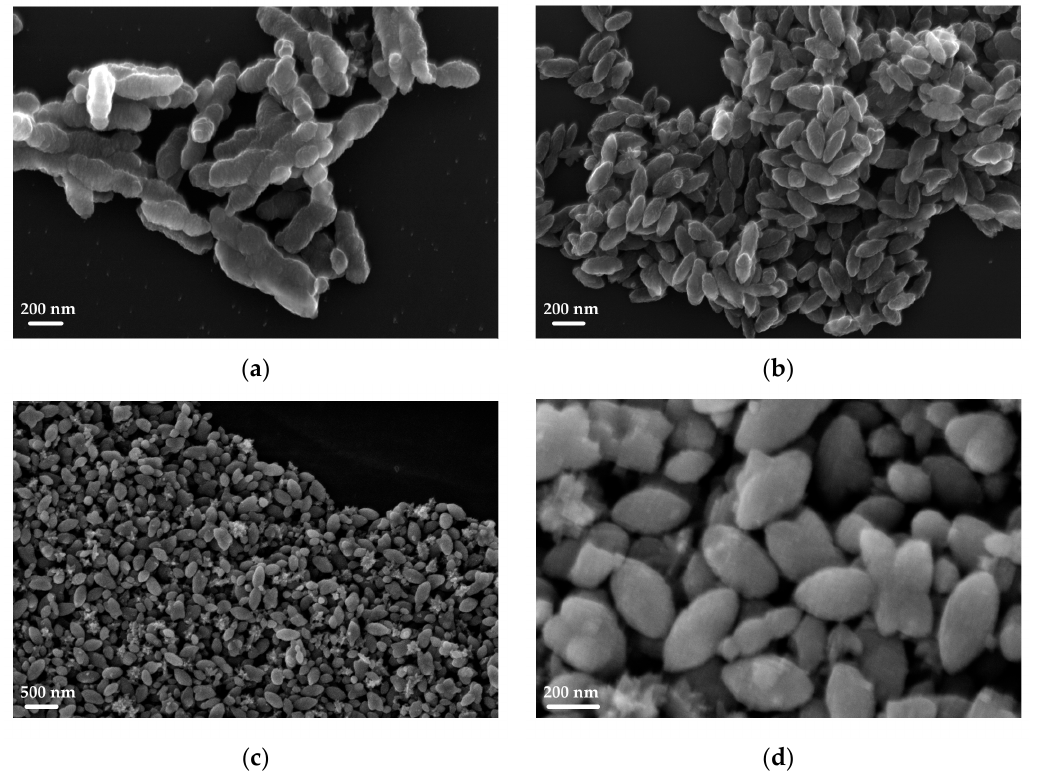
Figure 5. SEM images of TP23.4 ( a ), TP23.6 ( b ) and TP9 ( c , d ).